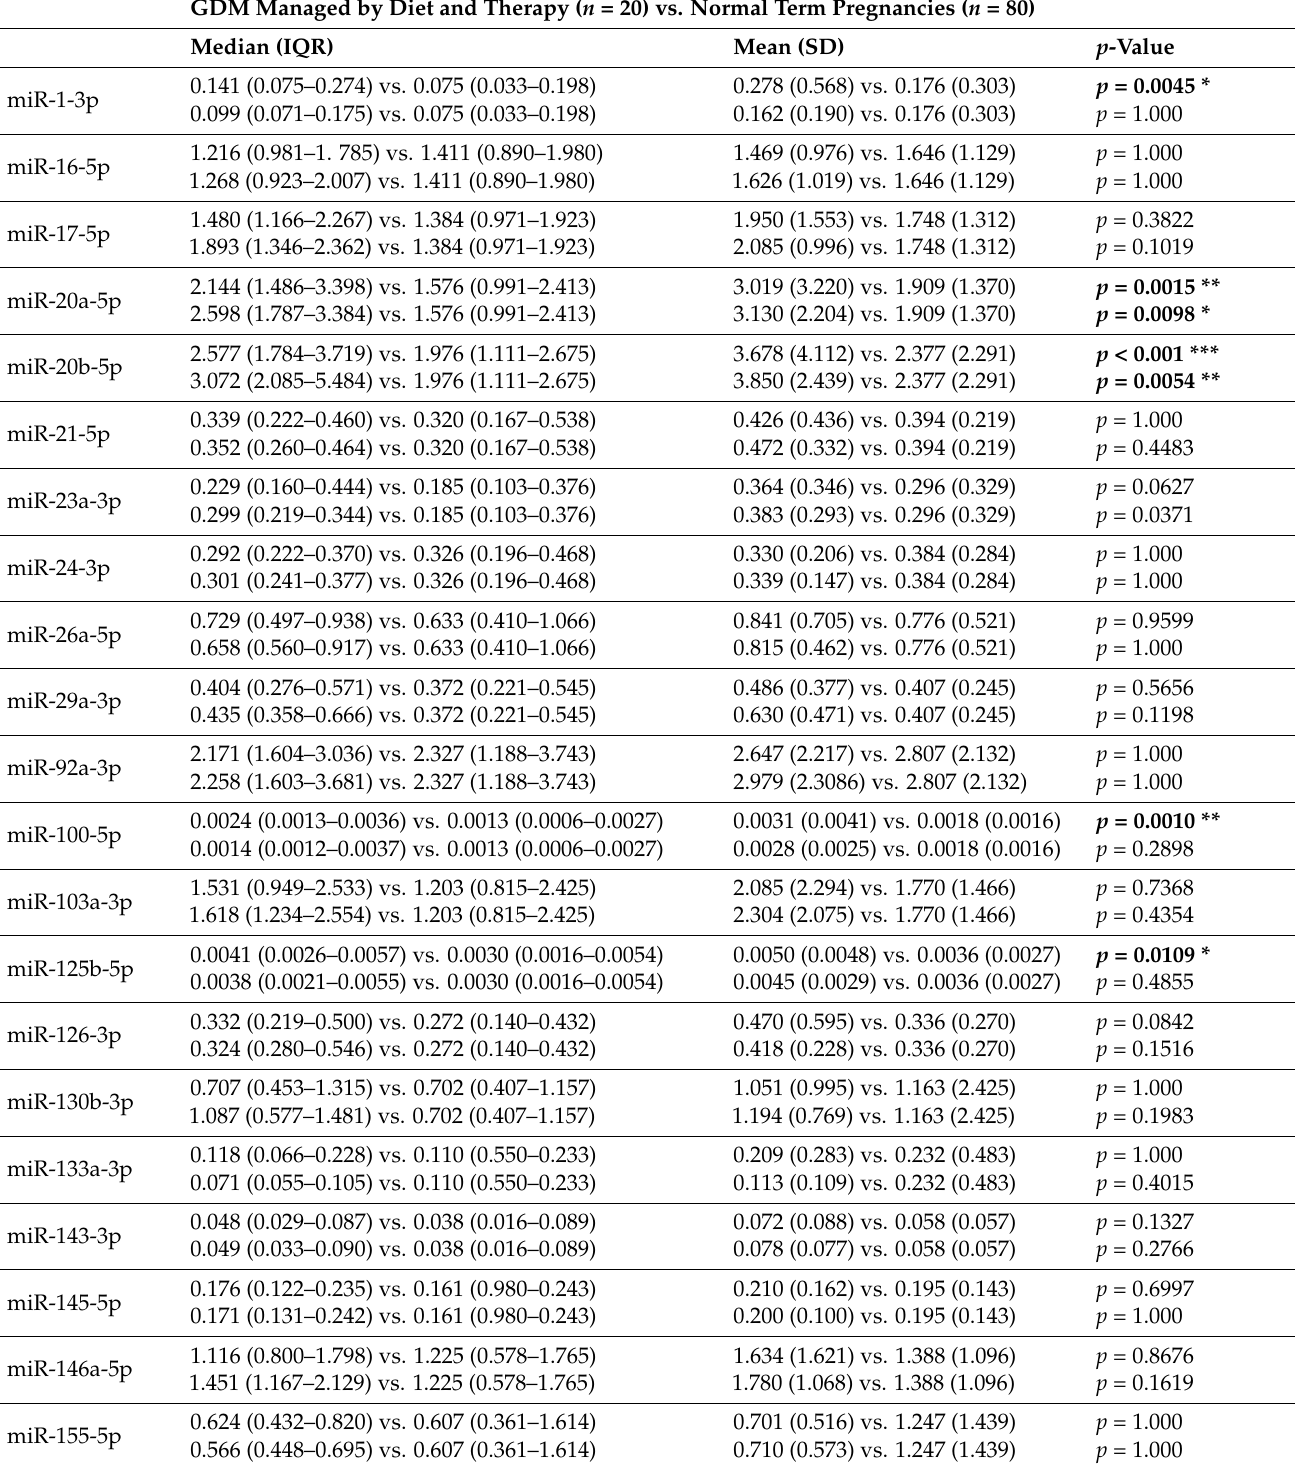
Table 4. MicroRNA expression profiles in peripheral blood leukocytes in early stages of gestation in pregnancies destinated to develop GDM with respect to the treatment strategies and normal term pregnancies. Kruskal–Wallis Test